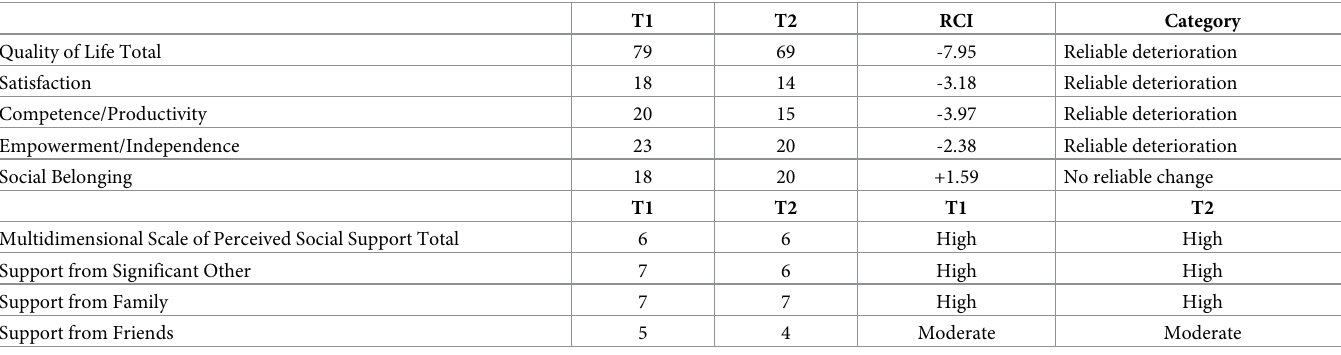
Table 7. Summary of QoLQ, RCI, and MSPSS categories for Mr. Reggie.